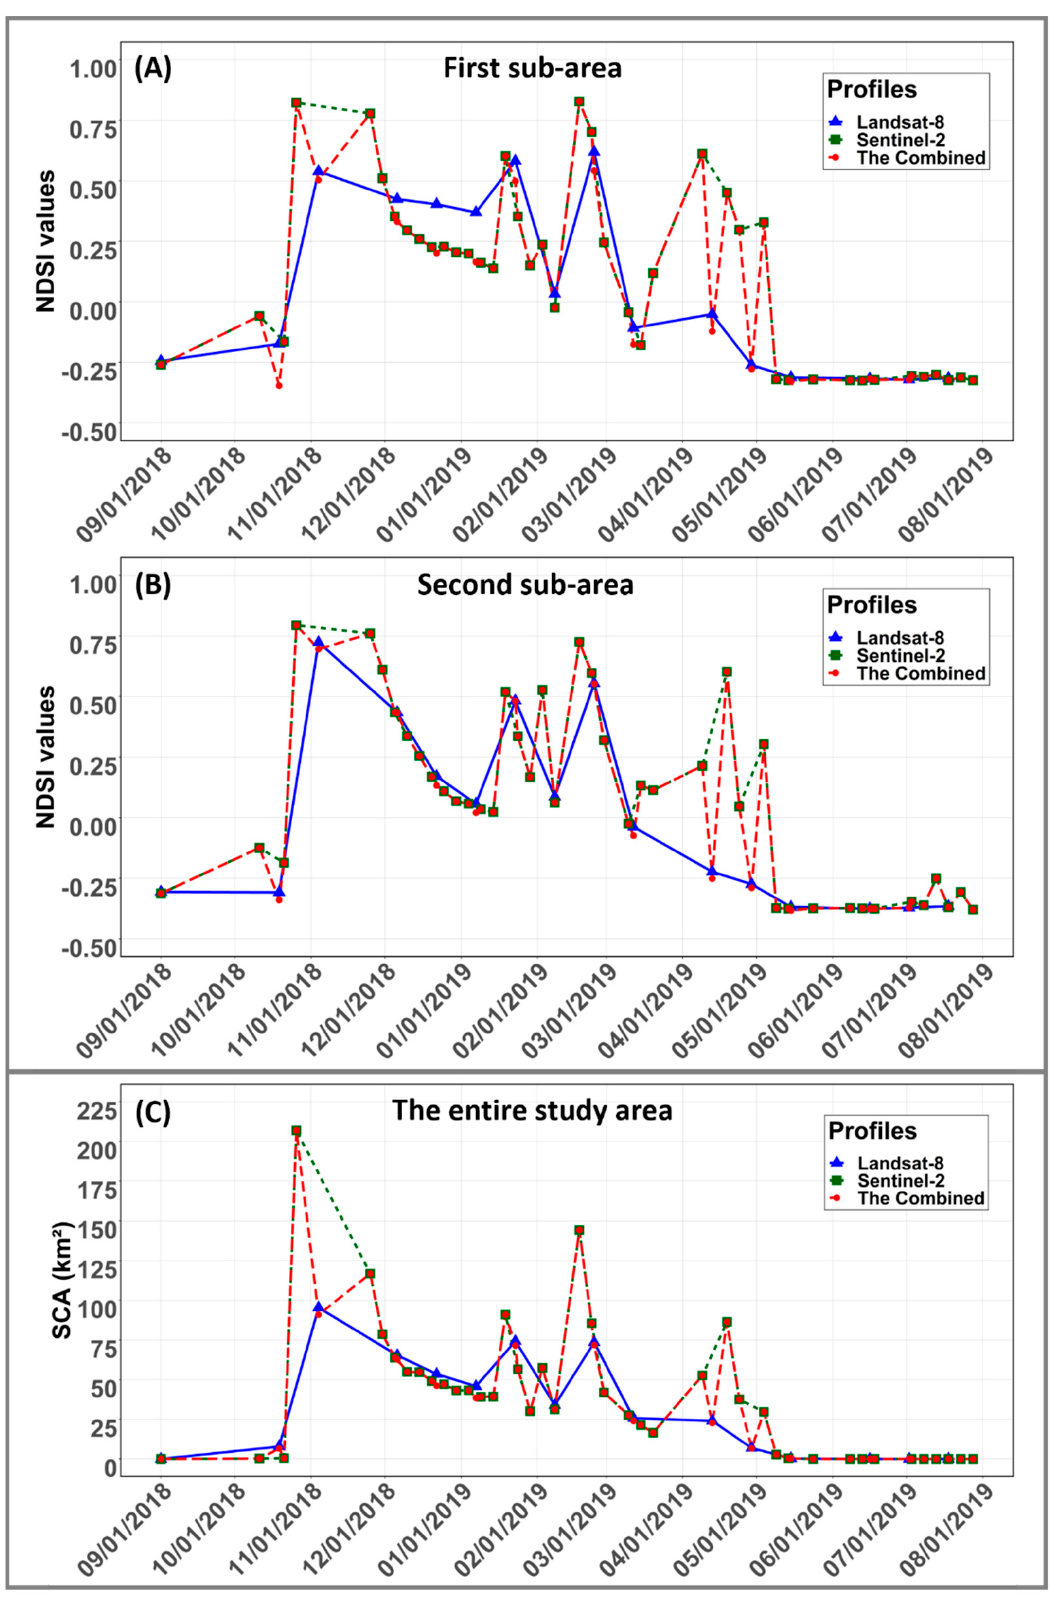
Figure 14. ( A , B ) Comparative analysis of NDSI time-series profiles over the two sub − areas, and ( C ) evolution of snow − covered area over the entire study area from September 2018 to August 2019, derived from S2, L8, and their fused exploitation by the pre − classification FSDAF fusion model.